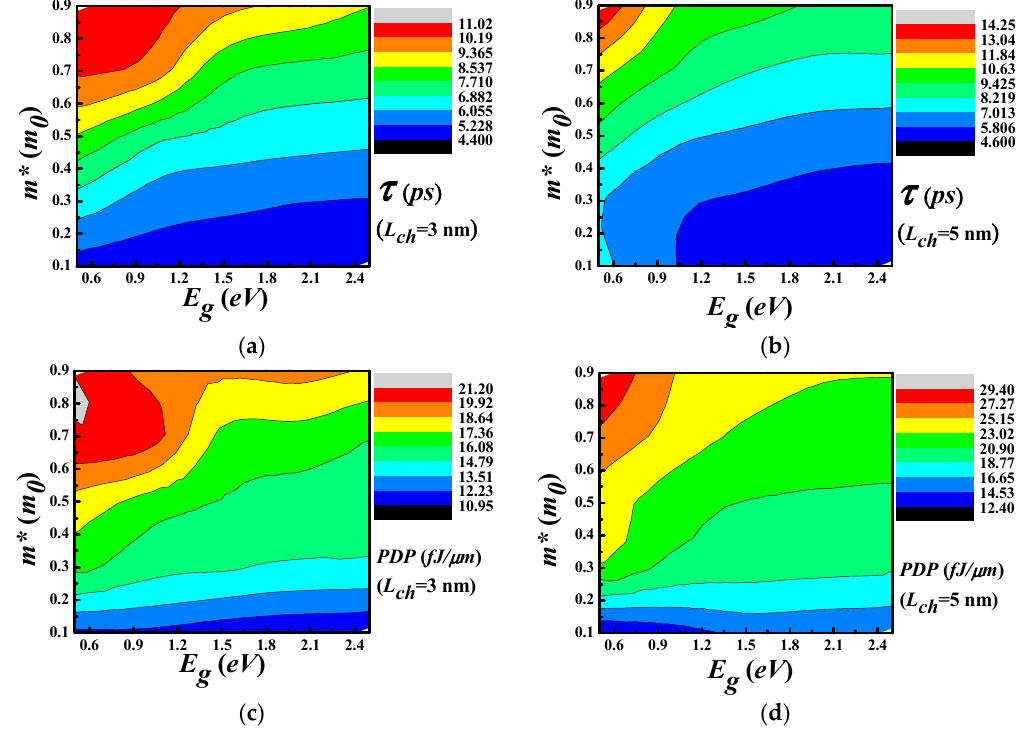
Figure 5. The delay ( a , b ) and PDP ( c , d ) of the devices as a function of the bandgap at di ff erent channel length of 3 nm and 5 nm.